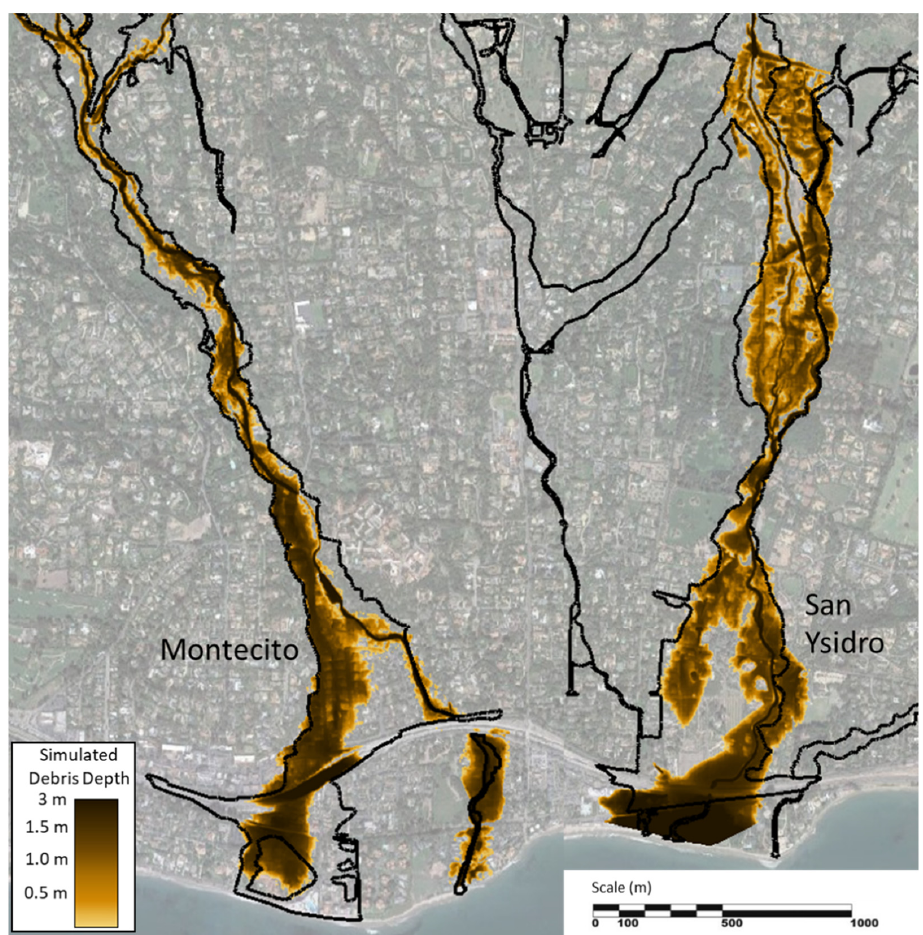
Figure 3. Santa Barbara debris flow models in HEC-RAS with Bessette-Kirton et al.’s (2019) [34] parameters.